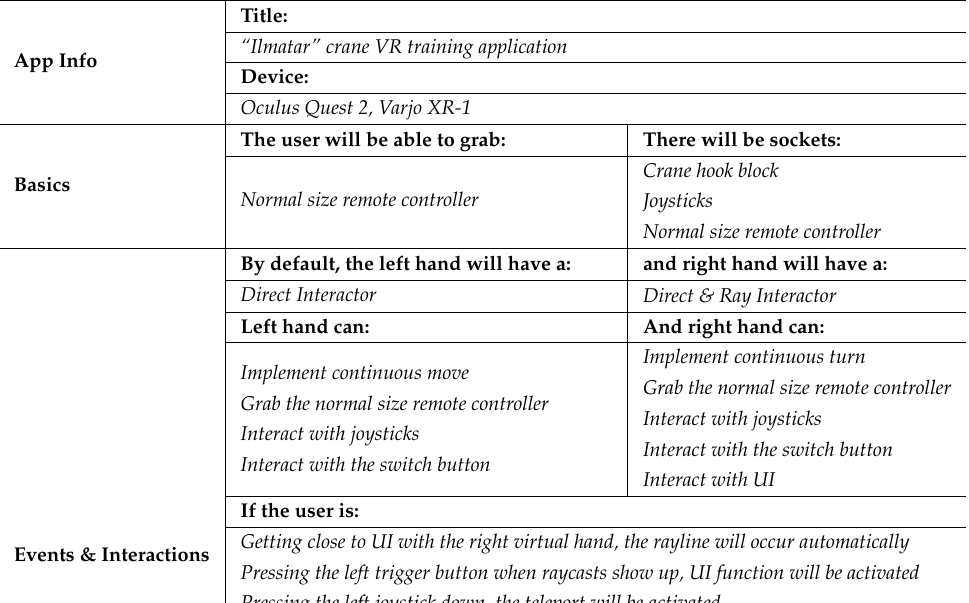
Table 6. VR training application design document: The functional features and the interaction features were developed following the design